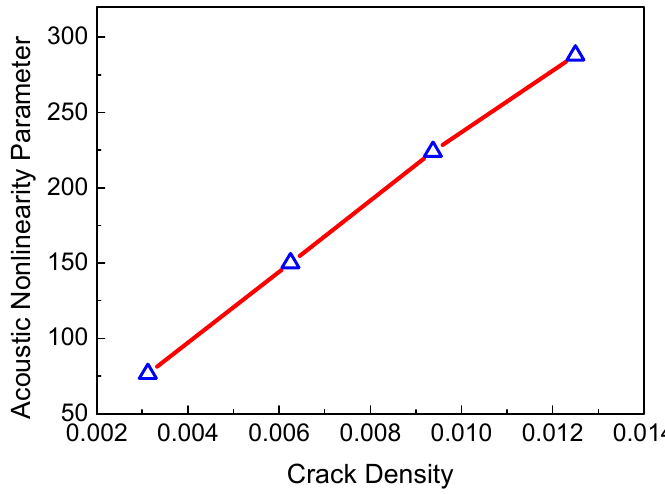
Figure 6. ANP versus crack density ( f R = 6 MHz, µ = 0, L 1 = 40 mm, L 2 = 4 mm, L 3 = 36 mm).